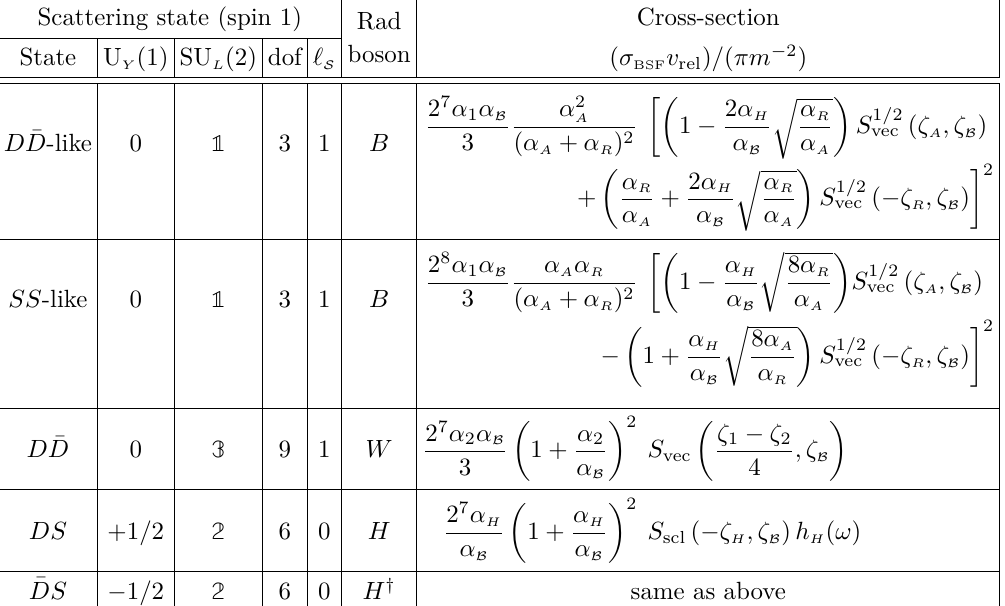
Same as table 7 for the D ¯ D bound states. Here, the bound-state coupling is α ( α + 3 α ) / 4 , and correspondingly ζ 1 2 should be evaluated from eq. (2.25) with ‘ suppression h , here ω = m (cid:2) ( α H